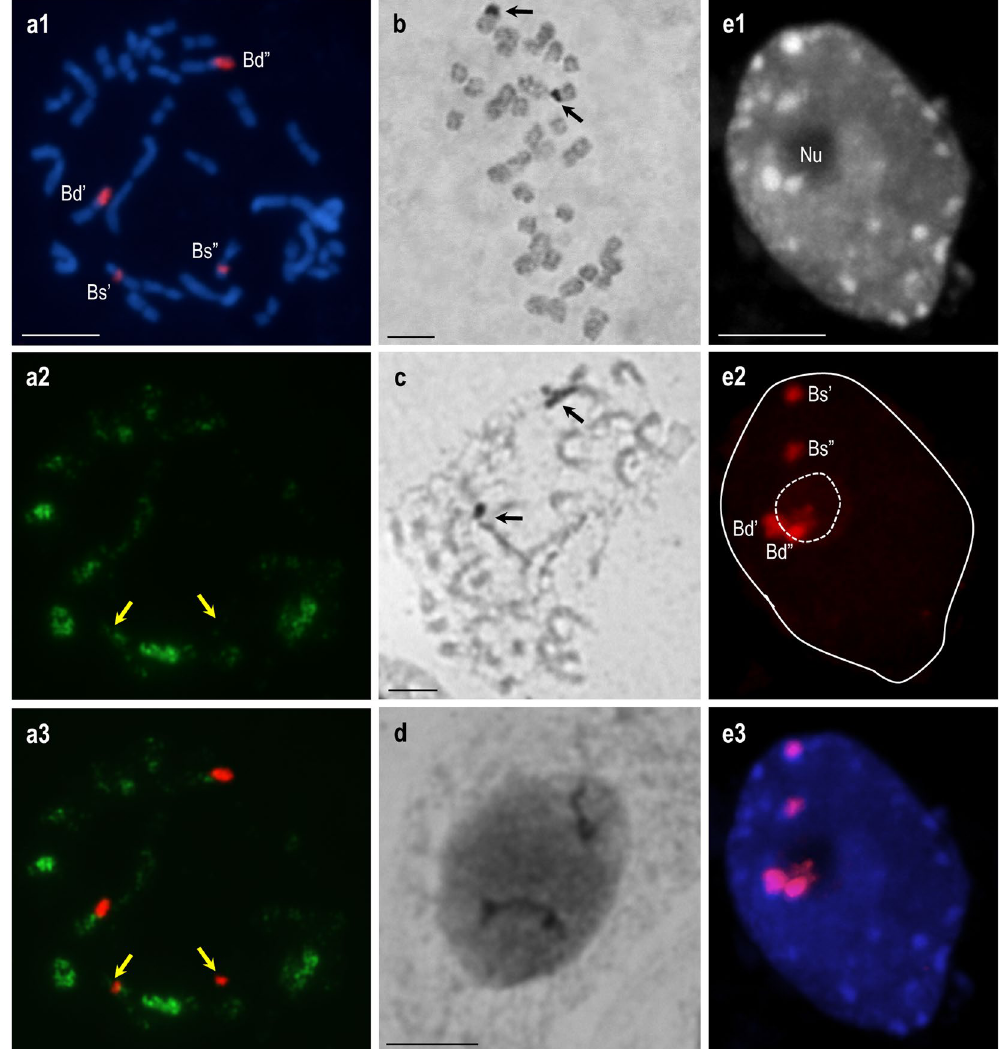
Figure 2. Impact of DNA hypomethylation caused by 0.1 mmol/L 5-AzaC on the preferential inactivation of 35S rRNA genes in the metaphase plates (a1–a3 ; c) and nuclei (d ; e1–e3) of B. hybridum (genotype ABR113). The 5-AzaC treatment changed neither the number of silver-stained loci, nor the non-nucleolar position of B. stacei -inherited 35S rDNA loci. (a1) FISH with 25S rDNA (red fluorescence) as a probe in the mitotic metaphase chromosomes. (a2) 5-MeC foci distribution in the metaphase spread shown on (a1 ). ( a3) Superimposed images of 25S rDNA FISH signals and anti-5-MeC signals. B. stacei- inherited loci are highlighted by yellow arrows. (b–d) The activity of 18S-5.8S-25S rDNA loci in the control (i.e. not treated with 5-AzaC) root-tip cells (b) and after 0.1 mmol/L 5-AzaC treatment in the metaphase plate (c) and interphase nucleus (d) . The Ag-NOR bands are highlighted by black arrows. (e1) DAPI counterstained nucleus. (e2) 25S rDNA hybridisation signals (red fluorescence). (e3) Superimposed images of 25S rDNA FISH signals and counterstained chromatin. Nu–nucleolus. Scale bar: 5 µ